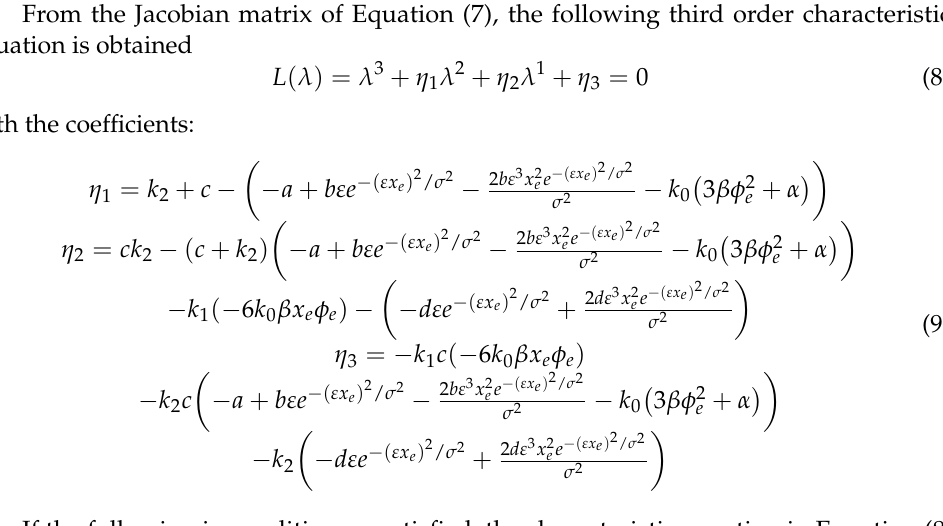
Figure 1. Time evolution of the AC equilibrium point of the considered tabu learning neuron model.